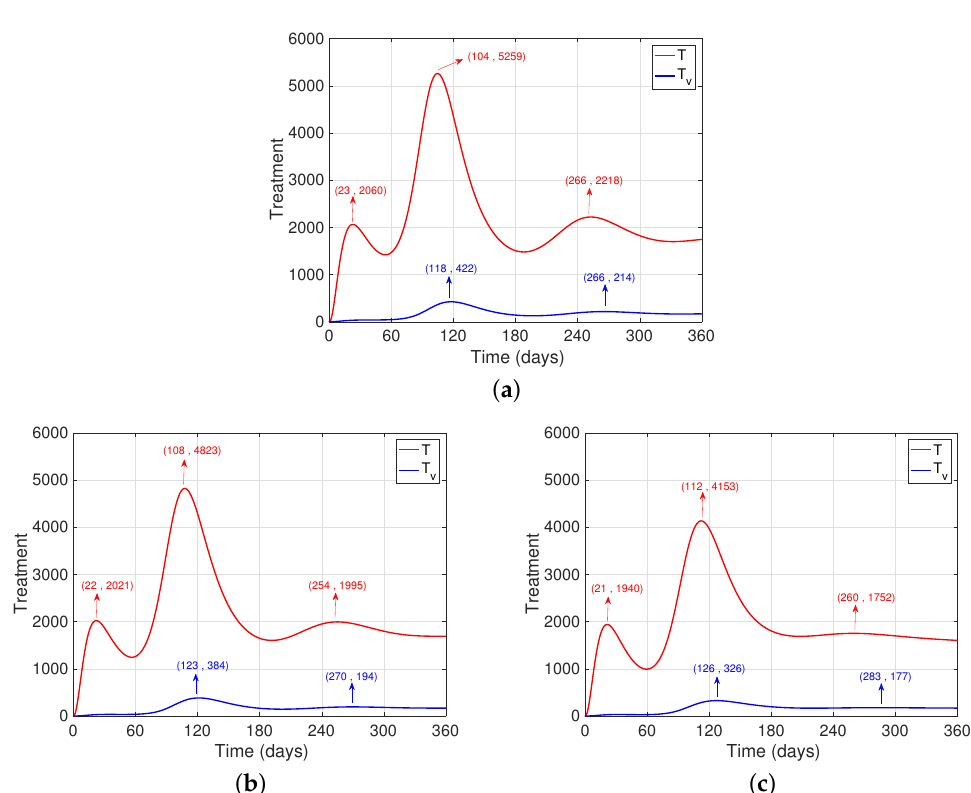
Figure 5. Dynamics of people who need some intervention after varying the baseline values of Risk Perception. ( a ) Base case. ( b ) Halving of the rate of resistance to change ( Λ 1 ), that is, people are less reticent to change their behavior and start adopting PPE and reduce social distancing. A similar graph is obtained after doubling the speed of people’s reaction to the pandemic ( Λ 2 ). ( c ) Reduction of resistance to change by half and increase in reaction speed by